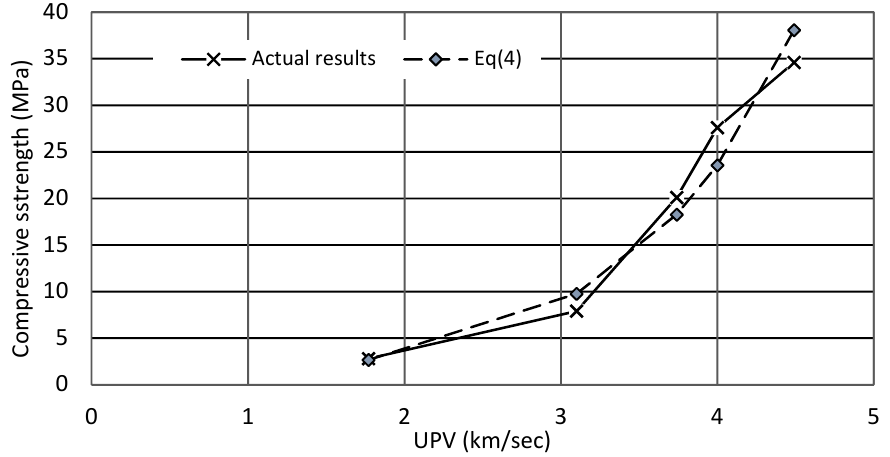
Figure 12. Actual compressive and predicted compressive based on Equation (4).